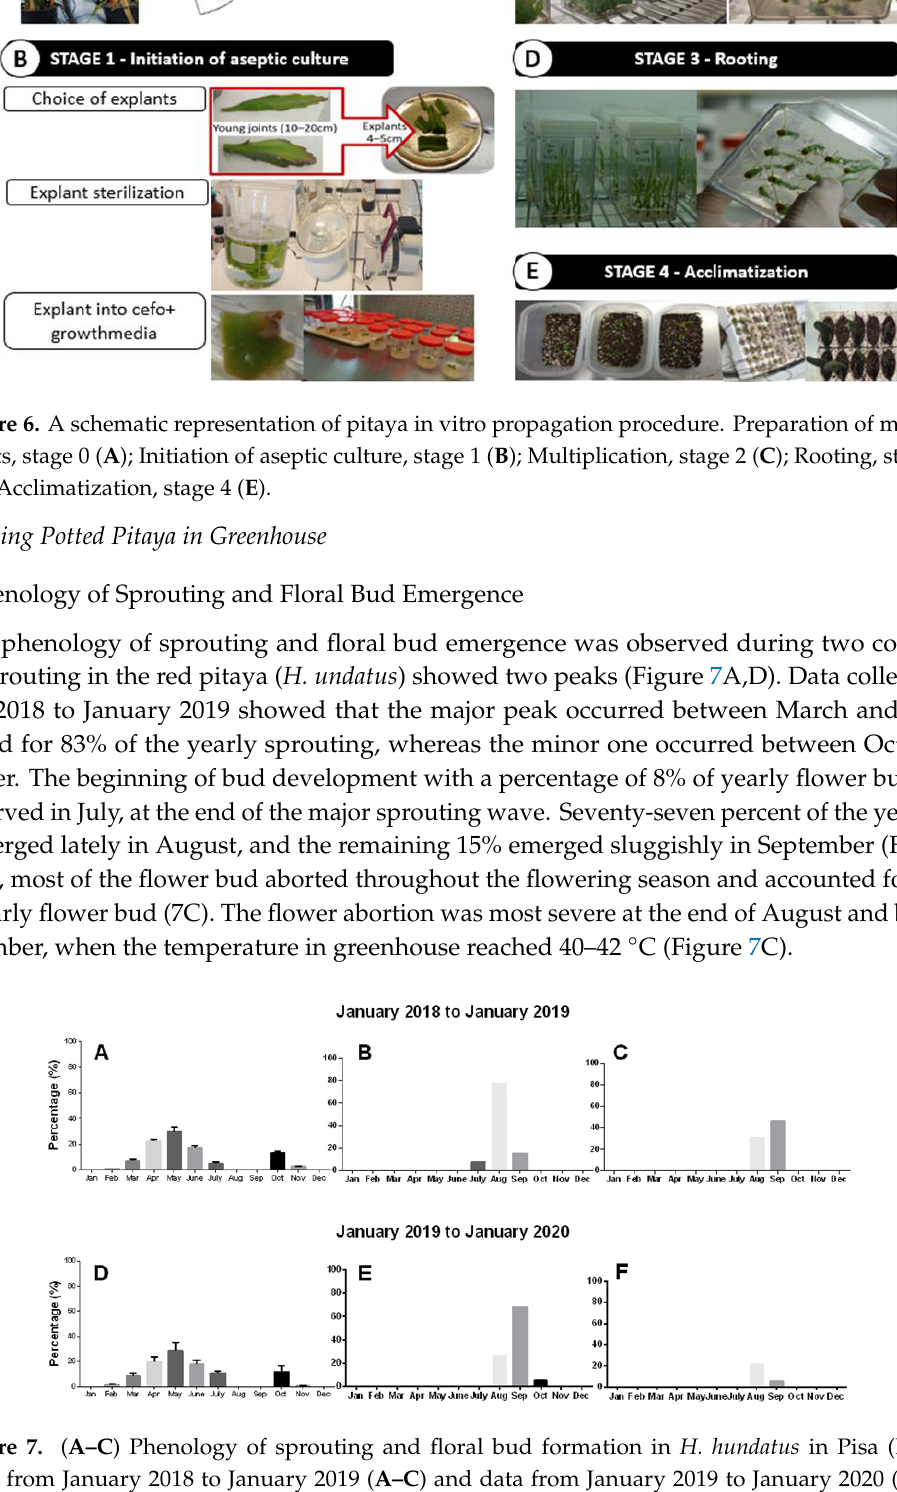
wise comparisons between group means. Abbreviations: 6-benzylaminopurine (BA); Indole−3- butyric acid (IBA).